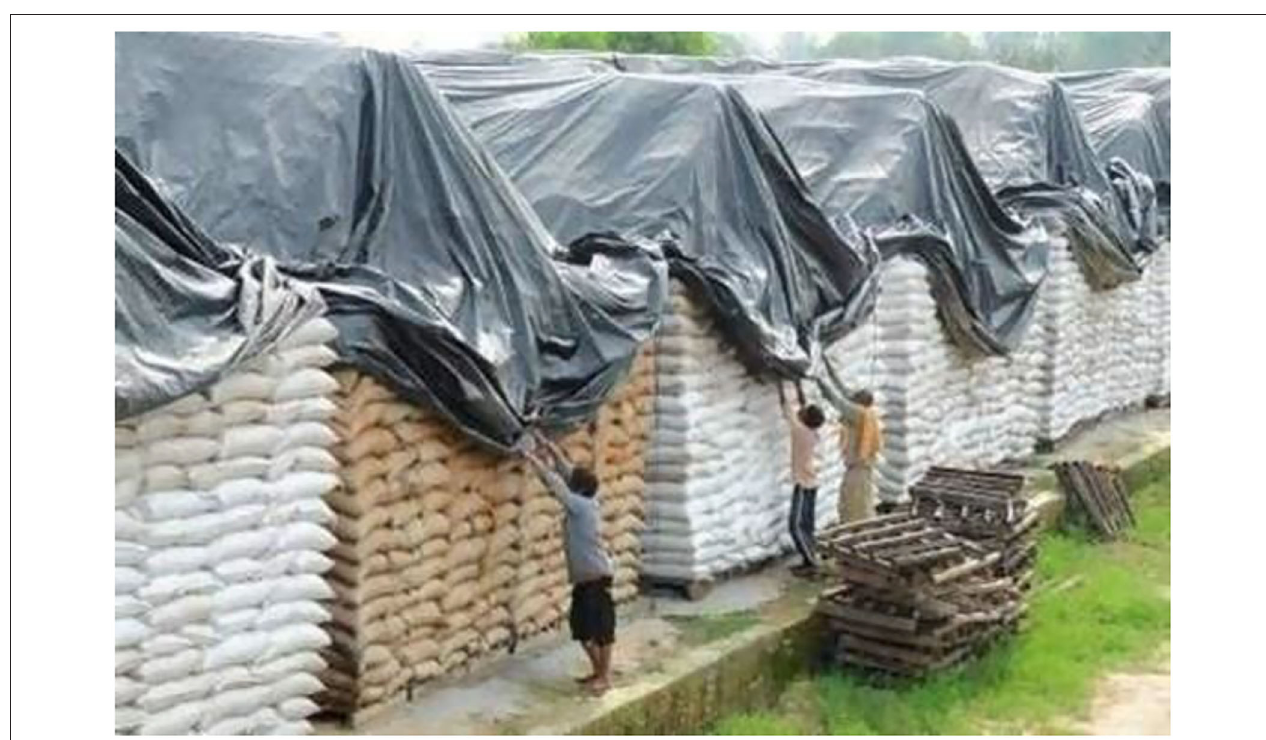
FIGURE 2 | A view of CAP storage.